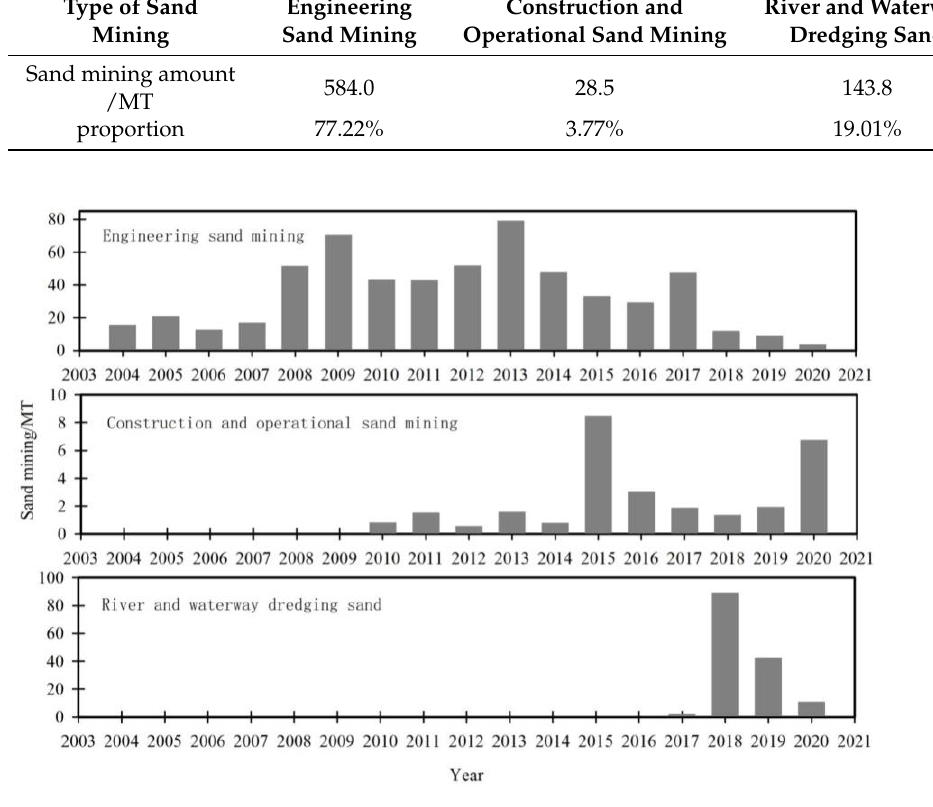
Figure 6. Sand mining by type during 2004 – 2020.